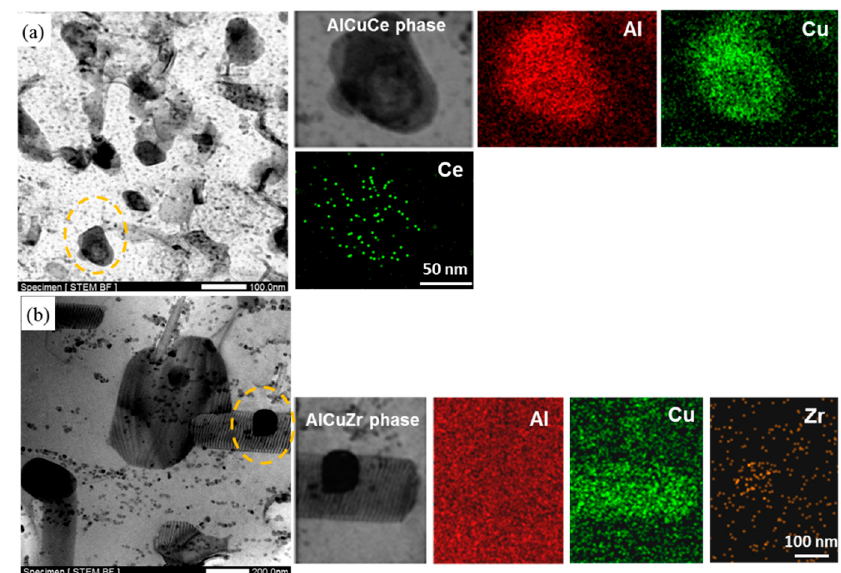
Figure 5. The characteristics and STEM-EDS mapping analysis of precipitates in ( a ) Ce-containing and ( b ) Ce-free alloys after exposure at 270 °C for 250 h.